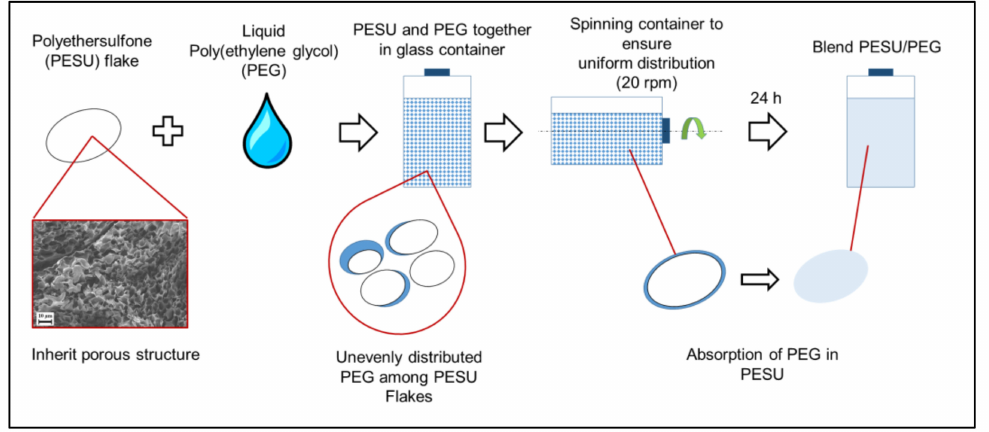
Figure 1. Schematic representation of the method followed for the blending of PEG with PESU. The mixture was dried for a minimum of 24 h at 50 ◦ C under vacuum before use. For foam extrusion, the blended flakes were used directly after drying, whereas for ma- terial characterization, the blended flakes were ground into powder using a grinder and particles < 350 µ m were filtered using an industrial